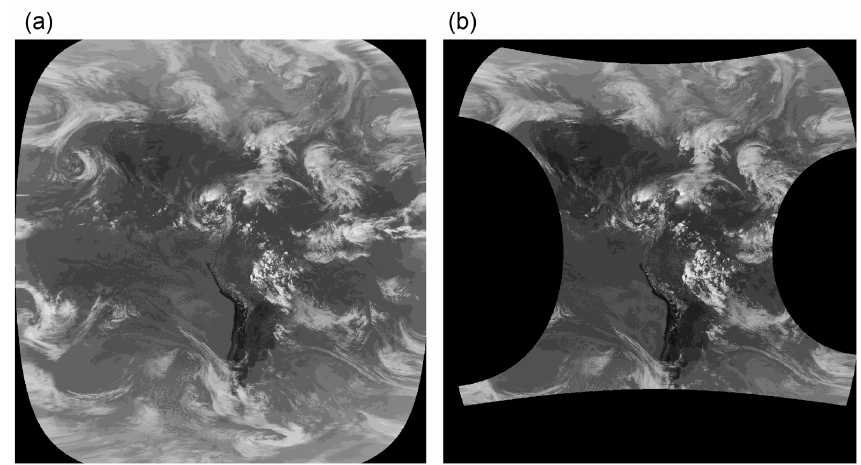
Figure 1. Sample of infrared window GridSat-GOES images for 18:00 and 19:00UTC. (a) The 18:00UTC image provided by a full disk scan that began at 17:45UTC. (b) The 19:00UTC image is a combination of three separate